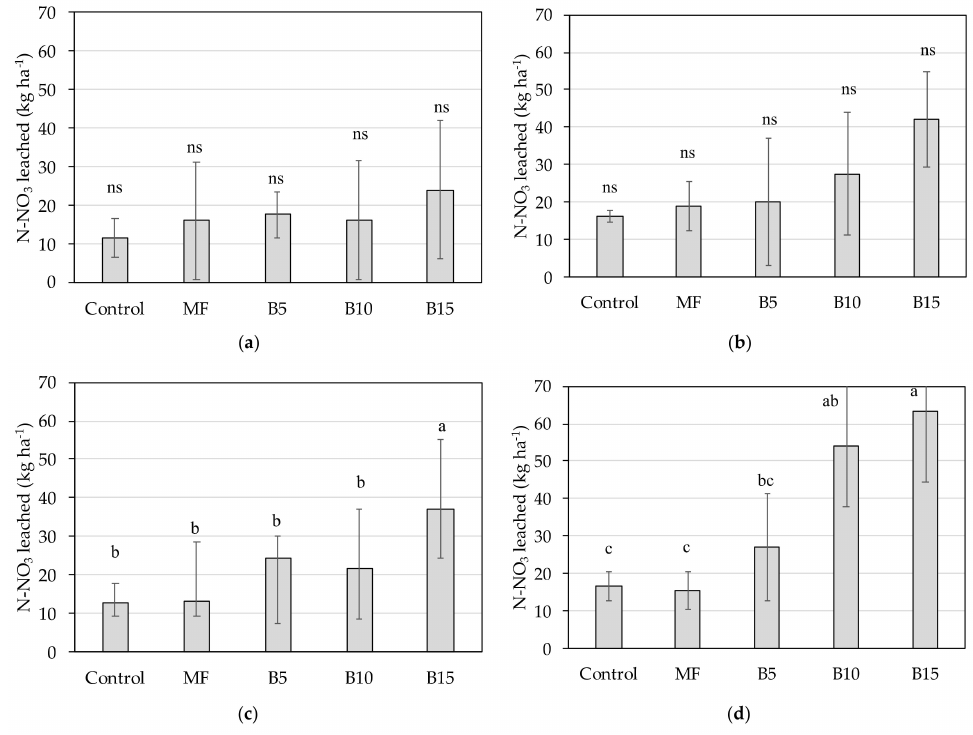
Figure 7. Total N-NO 3 leached, as affected by fertilization treatment in ( a ) barley; ( b ) common wheat; ( c ) durum wheat; and ( d ) oat. Bars with different letters are significantly different according to Tukey’s test ( p > 0.95). Error bars represent standard